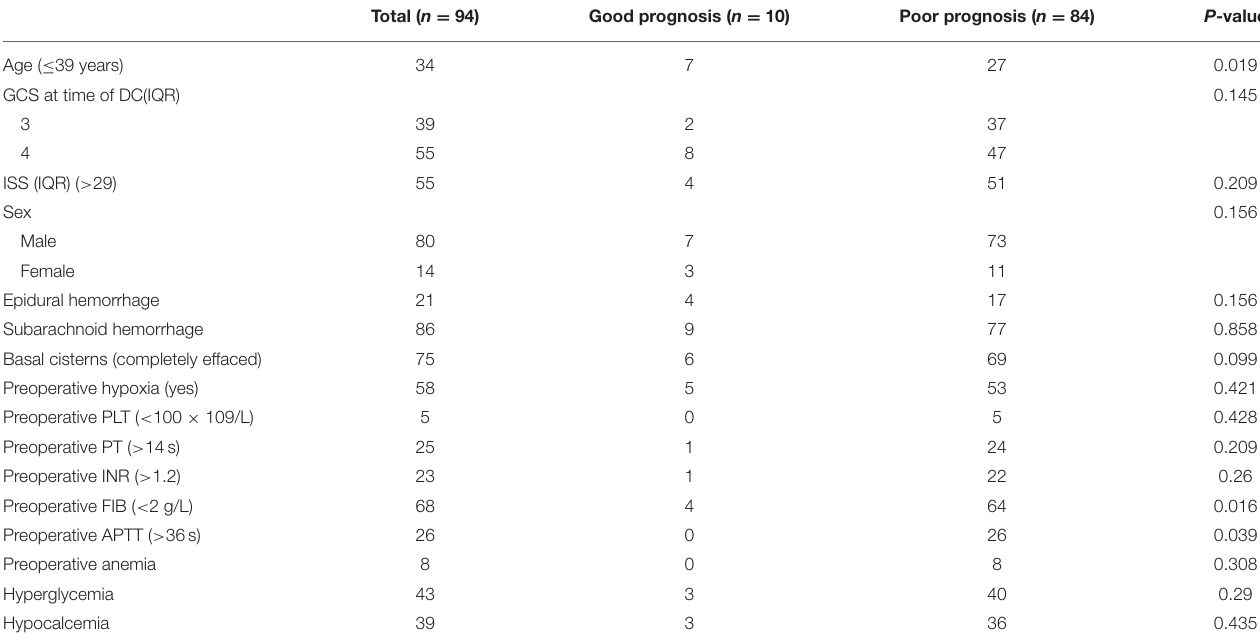
TABLE 4 | Comparison between good and poor outcomes with Glasgow Coma Scale < 5 and bilateral dilated pupils undergoing decompressive craniectomy. Total ( n = 94) Good prognosis ( n = 10) Poor prognosis ( n =